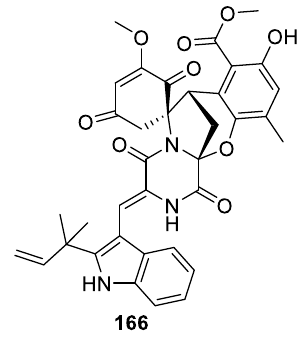
Figure 79. A [5.6.0] spirocyclic compound isolated from marine-derived fungus Eurotium sp. SCSIO F452.